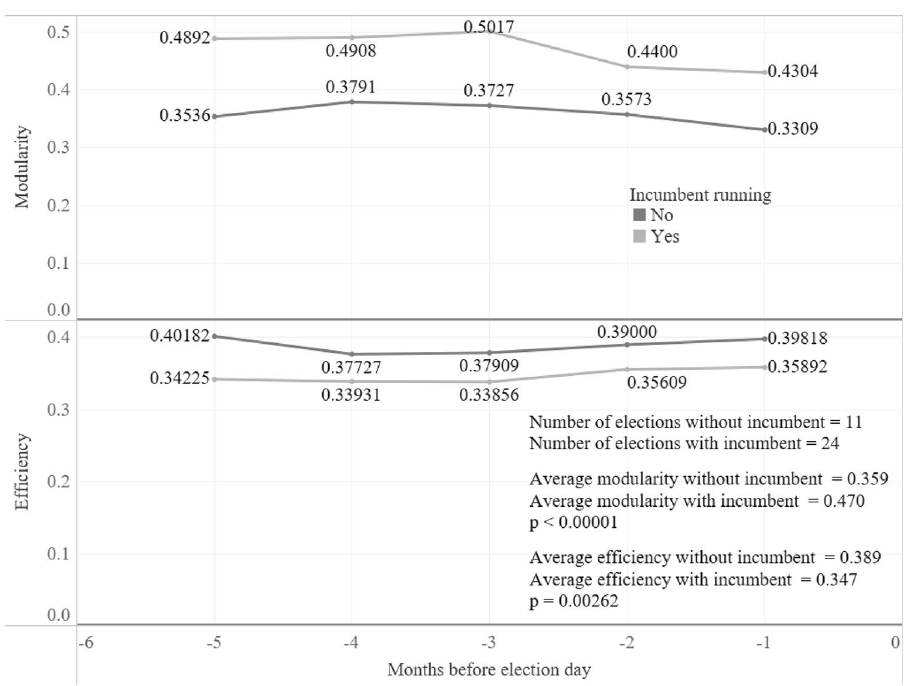
Figure 4. Evolution of modularity and efficiency according to whether the incumbent is running or not. A Mann–Whitney U Test was performed to determine if the differences between the means were statistically